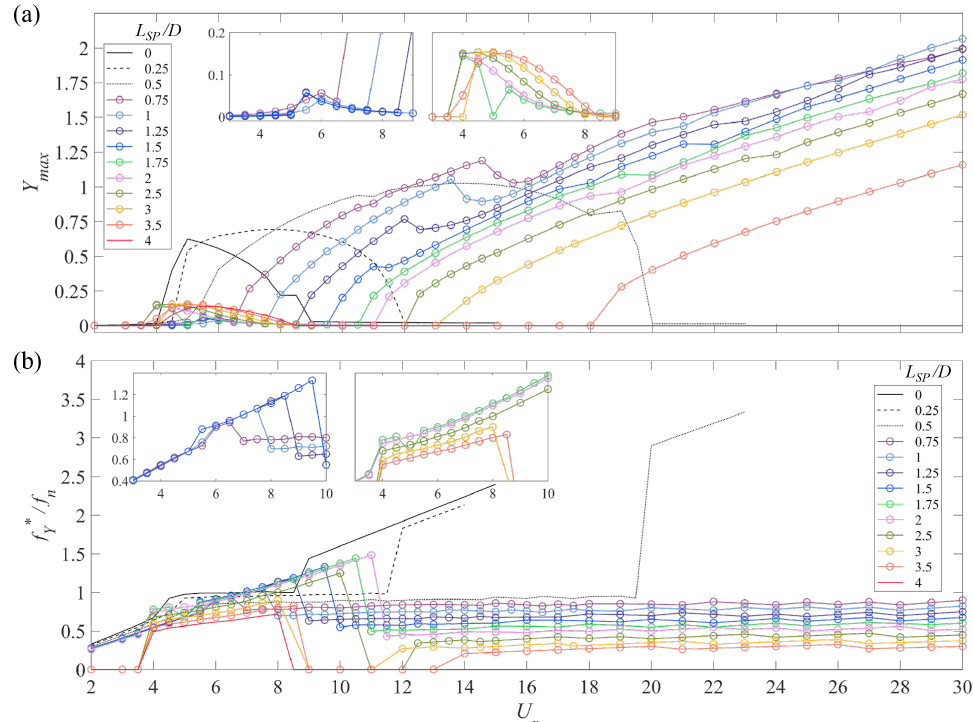
Figure 10. Plots of ( a ) the normalized vibration amplitude ( Y max ) and ( b ) the normalized dominant vibration frequency ( f ∗ / f n ) as a function of the reduced velocity U r stratified in terms of the splitter- Y plate length L SP